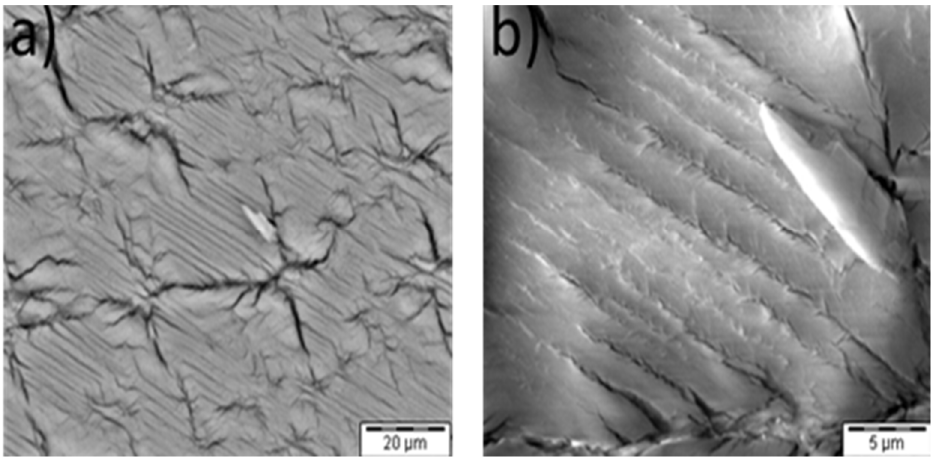
Figure 5. ( a , b ) Surface of the gypsum crystal after dehydration, SEM, low-vac mode.